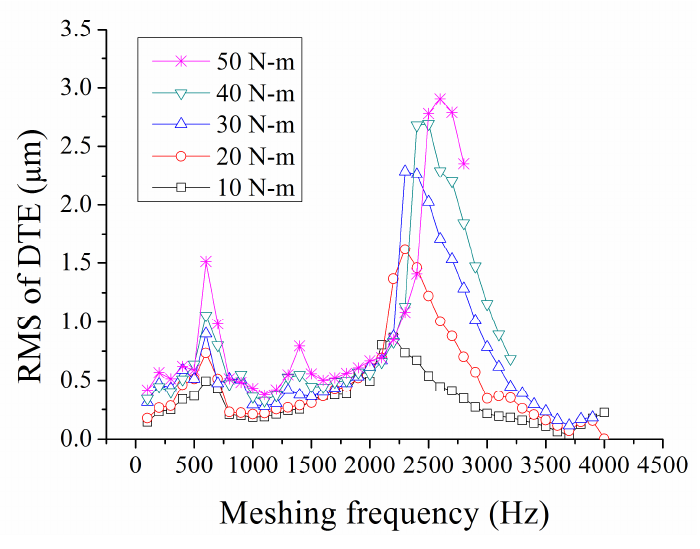
Figure 15. Experimental RMS of DTEs.